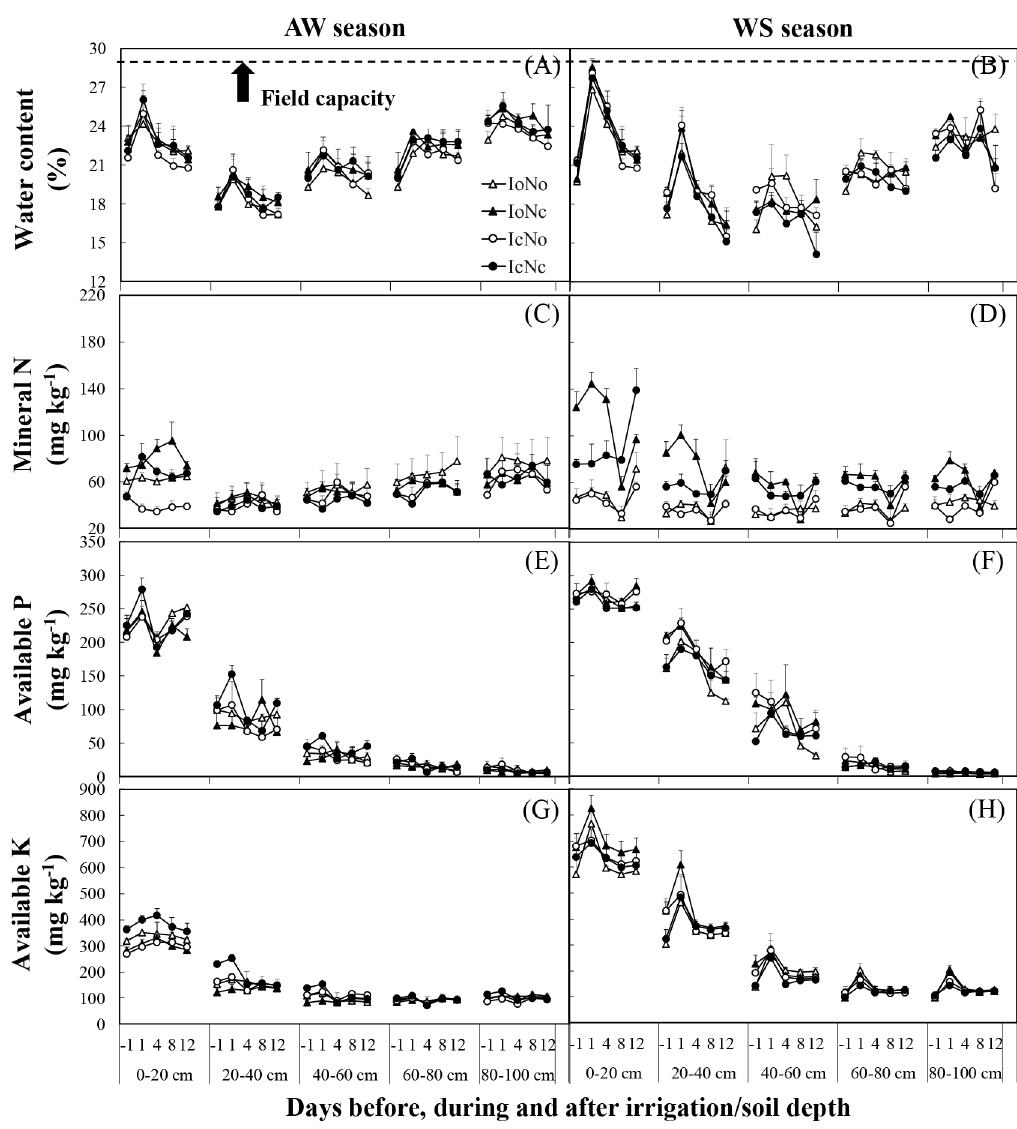
Fig 2. Changes of soil water content (A and B), mineral N (C and D), available P (E and F) and available K (G and H) under different treatments in the autumn-winter (AW) and winter-spring (WS) seasons. Treatments codes are the same as in Table 1. The numbers on the abscissa represent the days before (negative value), during (zero) and after (positive value) irrigation. Bars represent standard errors (n = 4).